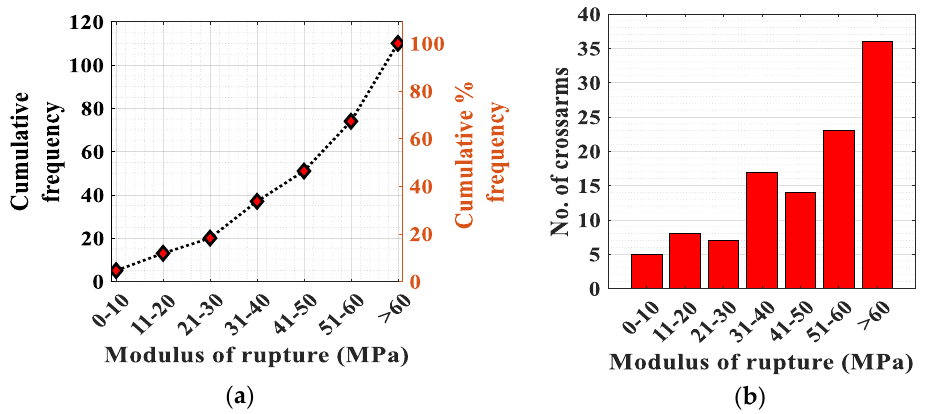
Figure 6. ( a ) Variation of the modulus of rupture—110 specimens; ( b ) groupings of the modulus of rupture.